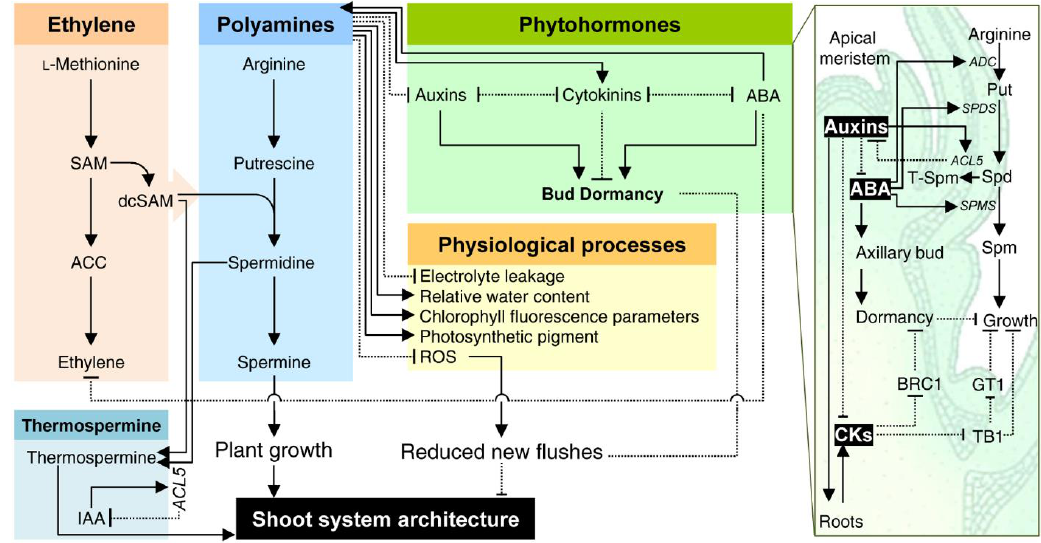
Figure 4. Hypothetical model of the integration of polyamines (PAs) with the major groups of phytohormones in the regulation of the shoot system architecture of citrus plants. Solid lines with arrows signify positive reaction, while round-dotted lines with bar-ends indicate negative interaction.